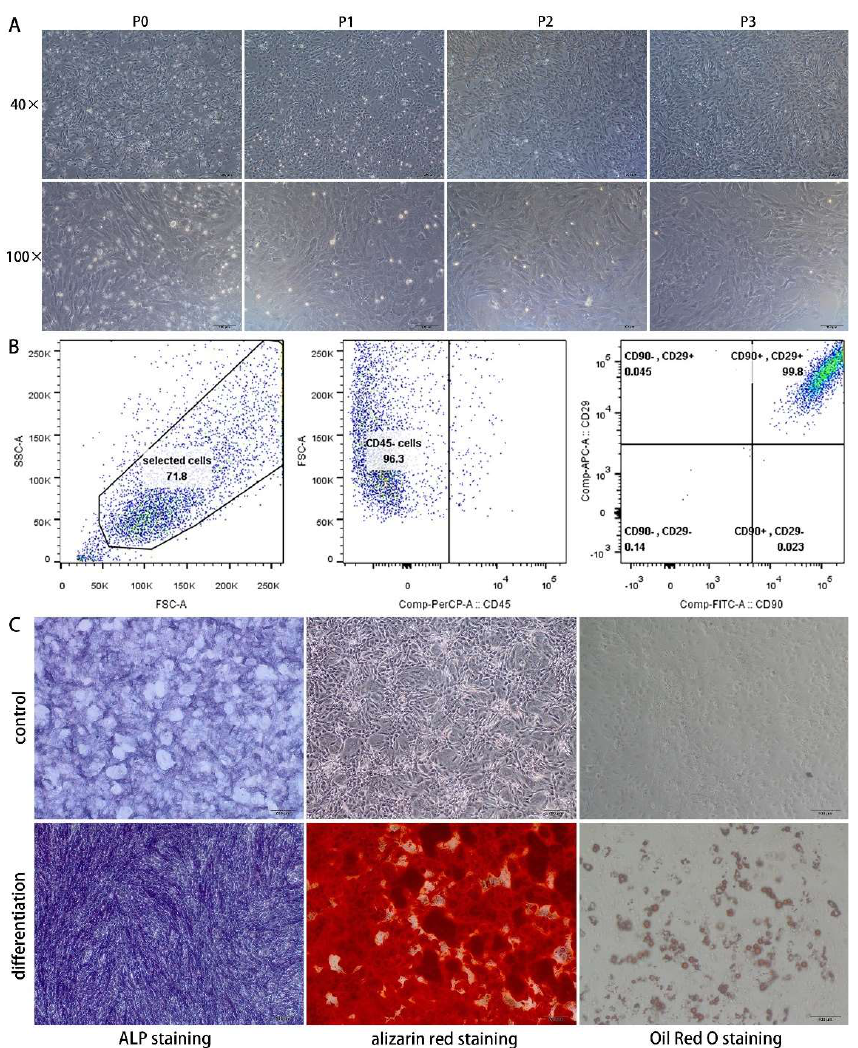
Figure 4. Morphology of BMSCs ( A ), flow cytometry analysis ( B ), and multipotent differentiation ( C ).